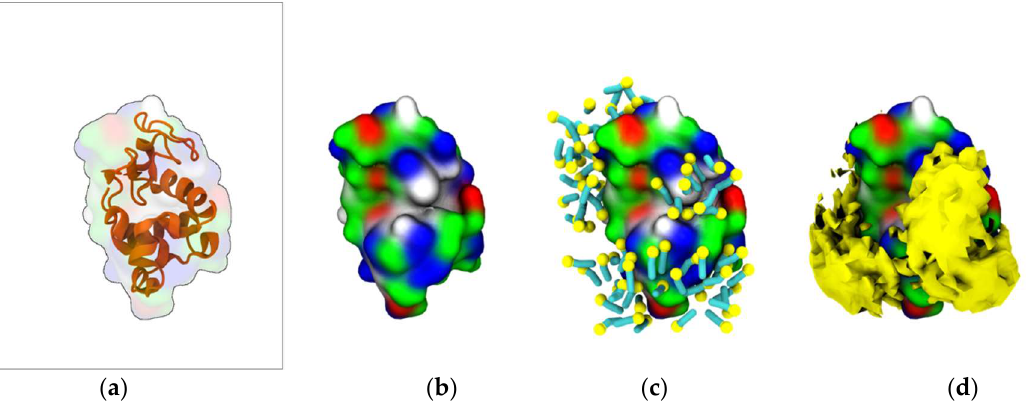
Figure 5. MD simulations of interaction between Lys and [N 1112(OH) ][C 4 F 9 SO 3 ]: ( a ) atomistic structure of Lys (PDB ID:1DPX); ( b ) CG structure of Lys; ( c ) [C 4 F 9 SO 3 ] - micelles interacting with Lys surface (C 4 F 9 —turquoise, SO 3 —yellow); ( d ) micelle occupancy. Protein surface residues are represented as polar (green), apolar (white), cationic (blue), or anionic (red). A second set of simulations was then carried out with two Lys molecules. In the absence of FIL, the two Lys molecules interacted frequently, but always dissociated within the µs timescale (simulations were run too close to 100 µs due to these unbinding